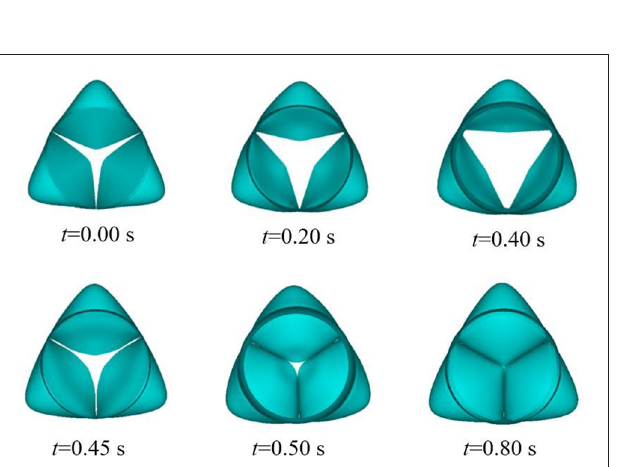
FIGURE 5 | Aortic valve opening and closing process in finite element numerical simulation.